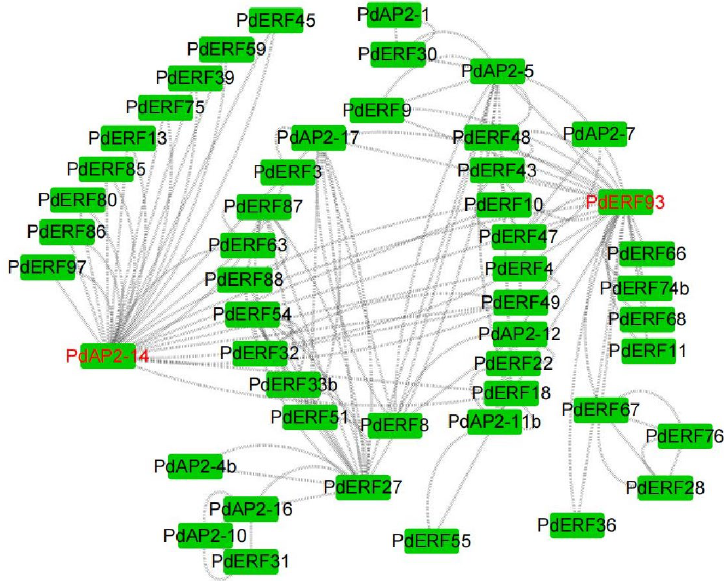
Figure 10. Protein‒protein interaction network of PdAP2/ERF members. Red gene names represent central genes. The black dashed line represents the interaction between different proteins.